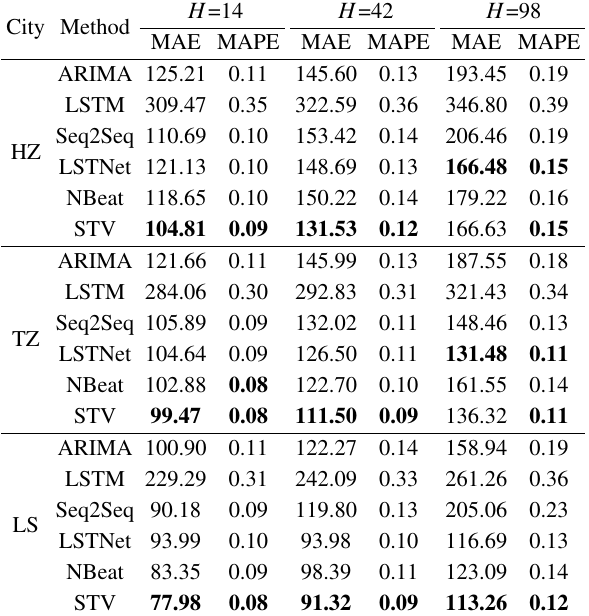
Table 1 Overall MAE and MAPE of different